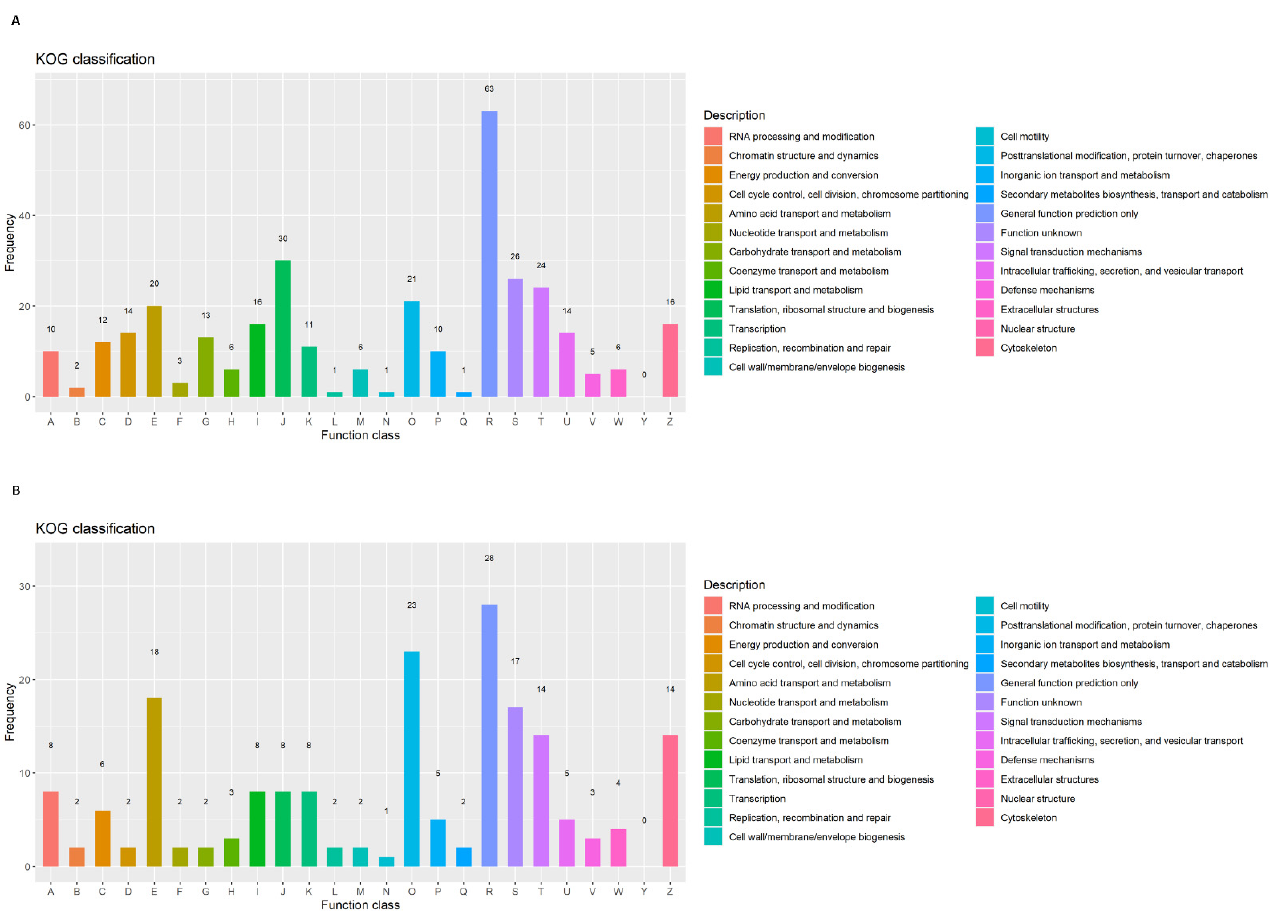
Figure 5. KOG annotation of DEGs in differentially resistant strains following inoculation. ( A ) DEGs in p50+ vs. p50 − group, ( B ) DEGs in C108+ vs. C108 − group.